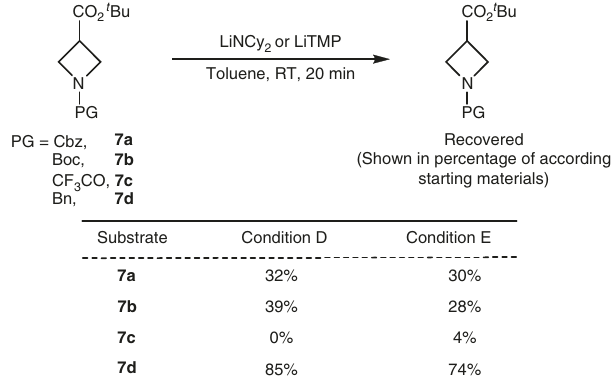
Fig. 10 Stability of different azetidine esters. Condition D: PG-azetidine (1 equiv.), LiNCy 2 (2 equiv.), toluene, RT, 20 min. Then MeOH; Condition E: PG-azetidine (1 equiv.), LiTMP (1.05 equiv.), toluene, RT, 20 min. Then MeOH. PG: protecting